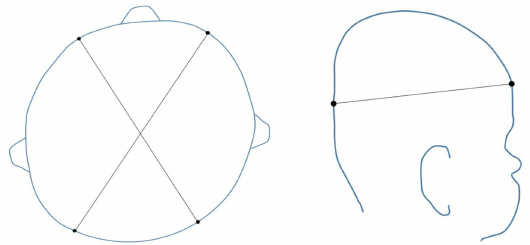
Figure 1. Illustration of cranial measurement locations. The superior view on the left illustrates the diagonal measurement locations used in the calculation of the cranial vault asymmetry index (CVAI). The absolute value of the di ff erence of these two diagonal measurements is defined as the cranial vault asymmetry (CVA). The lateral view on the right illustrates the location of the greater equator of the skull, where diagonal measurements are